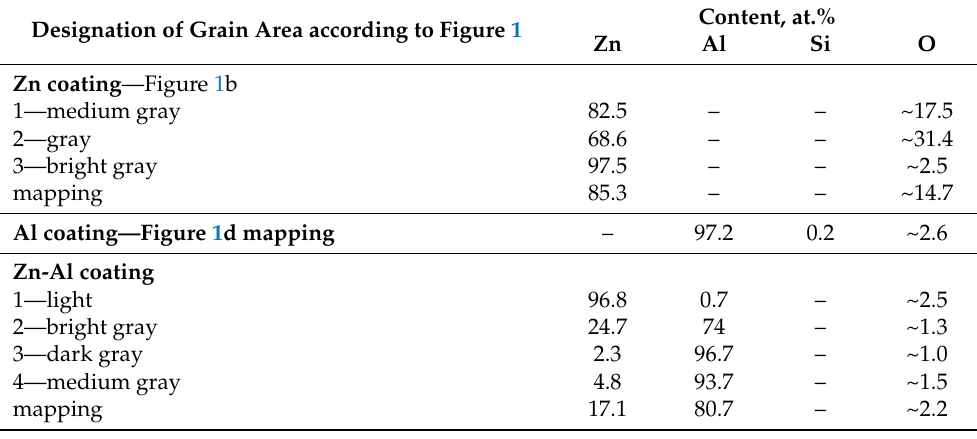
Table 5. Semiquantitative EDS analysis (at.%) of as-arc wire sprayed with three types of coatings (Zn, Al, and